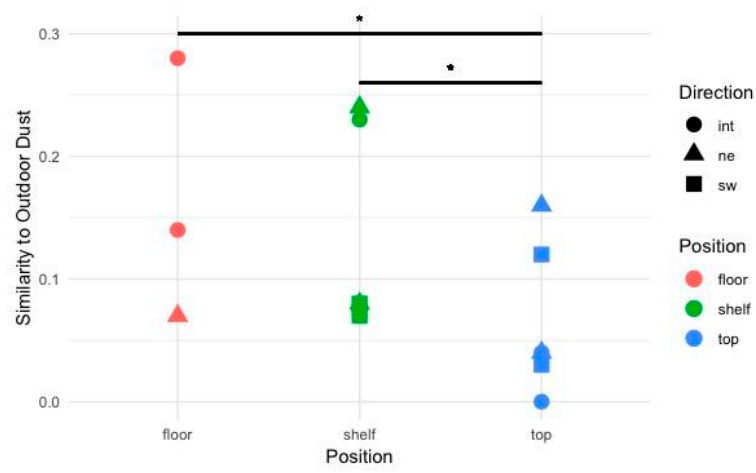
Figure 7. Similarity of indoor air bacterial communities to on-site outdoor air bacterial communities. Communities sampled from the top of the unit were significantly less like outdoor bacterial communities than those from the floor or shelf height.